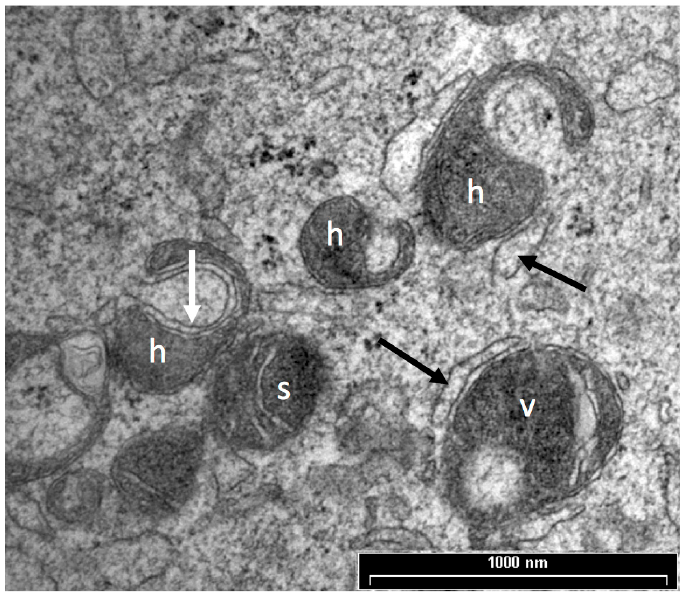
Figure 1. TEM image of spherical (s), hooded (h) and vacuolated (v) mitochondria in an in vitro matured adult sheep oocyte. Smooth endoplasmic reticulum can be observed closely associated with the outer mitochondrial membrane (black arrows) and within the hood of the mitochondria (white arrow). Scale bar = 1 μ m.